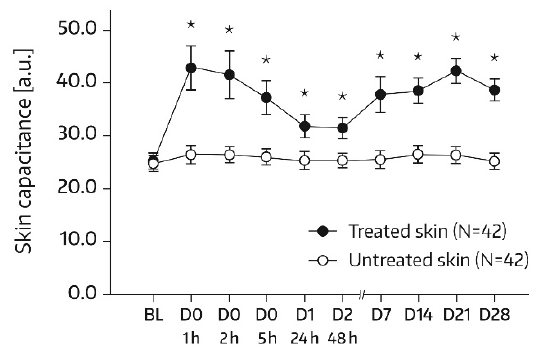
Figure 2. Results from skin capacitance measurements in untreated skin and skin undergoing a single application of Emollient 1 (first 48 h) followed by once-daily application for 26 days. The values were assessed by corneometry and are presented as mean ± SD. BL = Baseline skin capacitance value before first product application; D = day; h = hour. * p < 0.001 if compared to untreated control, paired t -test.